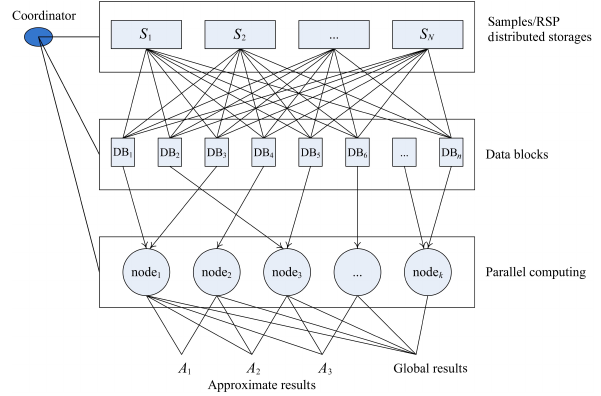
Fig. 7 Distributed approximate